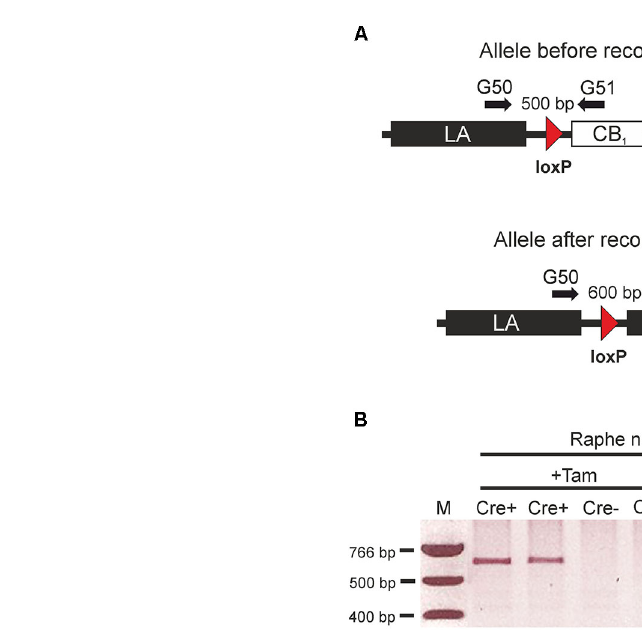
[ T ( 90 ) = 0.3604; p = 0.719]; Sociability-Habituation: 930.7 ± 48.96 cm for TPH2-CB 1 − / − [ n = 18] and 1096 ± 53.47 cm for TPH2-CB 1 + / + [ n = 201]; [ T ( 369 ) = 1.91337; p = 0.0637], Sociability phase: 4436 ± 82 cm for TPH2-CB 1 − / − [ n = 18] and 4680 ± 167 cm for TPH2-CB 1 + / + [ n = 21]; [ T ( 37 ) = 0.1458; p =